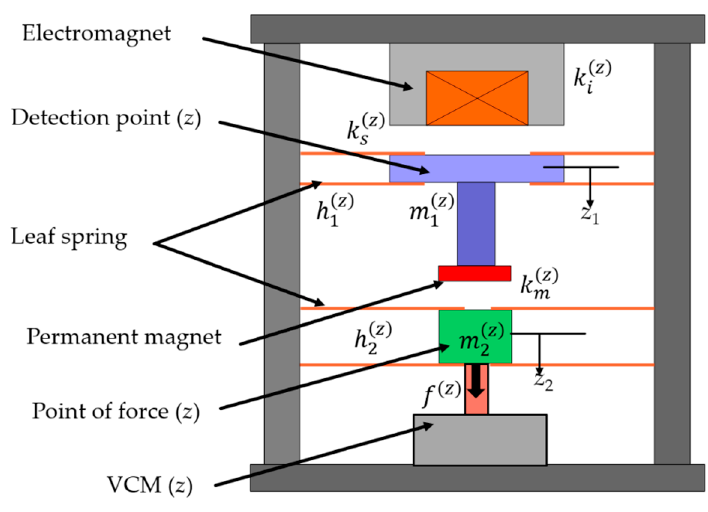
Figure 3. View of the vertical axis force estimation operation [23].